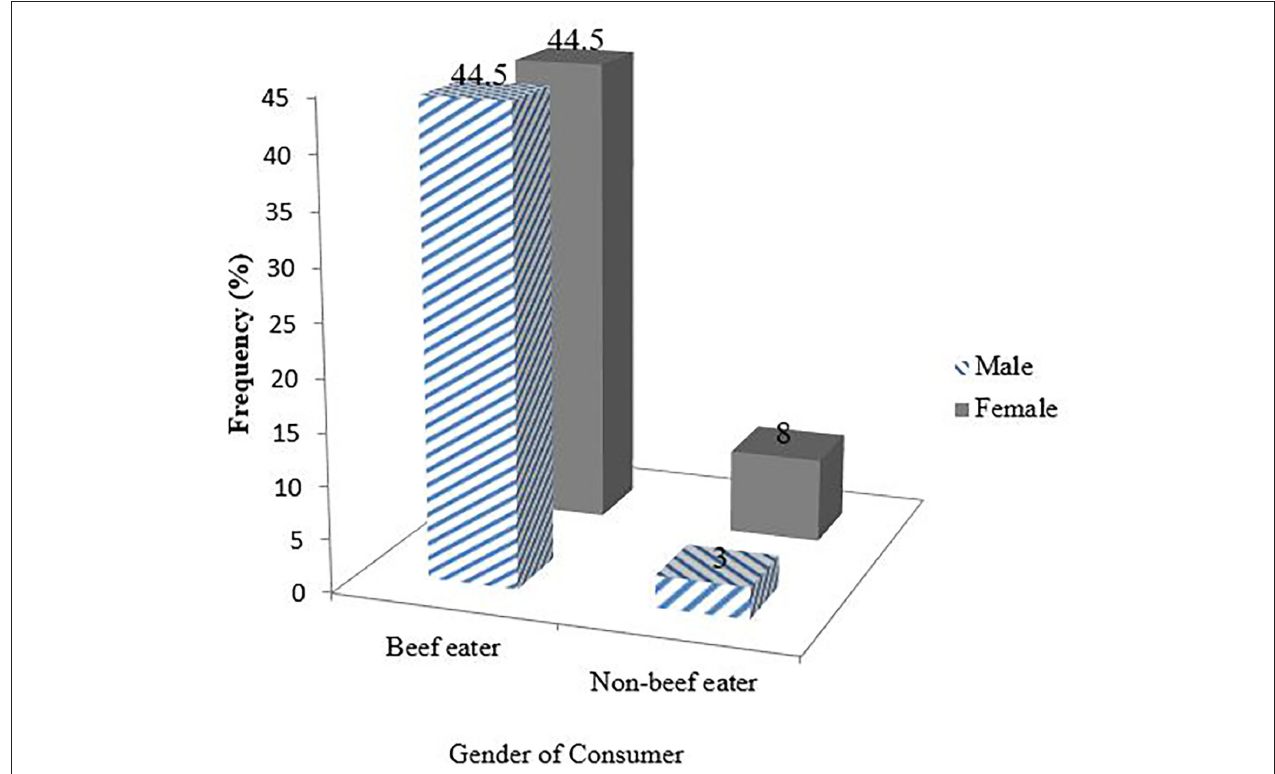
FIGURE 1 | Effect of gender on consumption of conventional beef in the Eastern Cape province of South